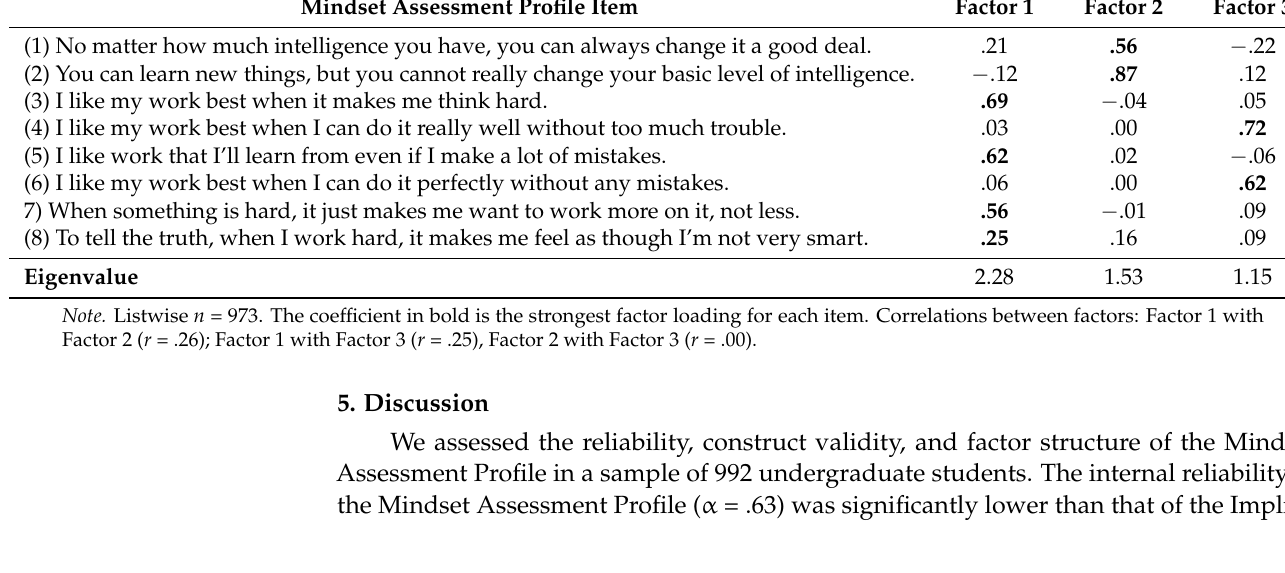
Table 4. Exploratory factor analysis of the Mindset Assessment Profile. Mindset Assessment Profile